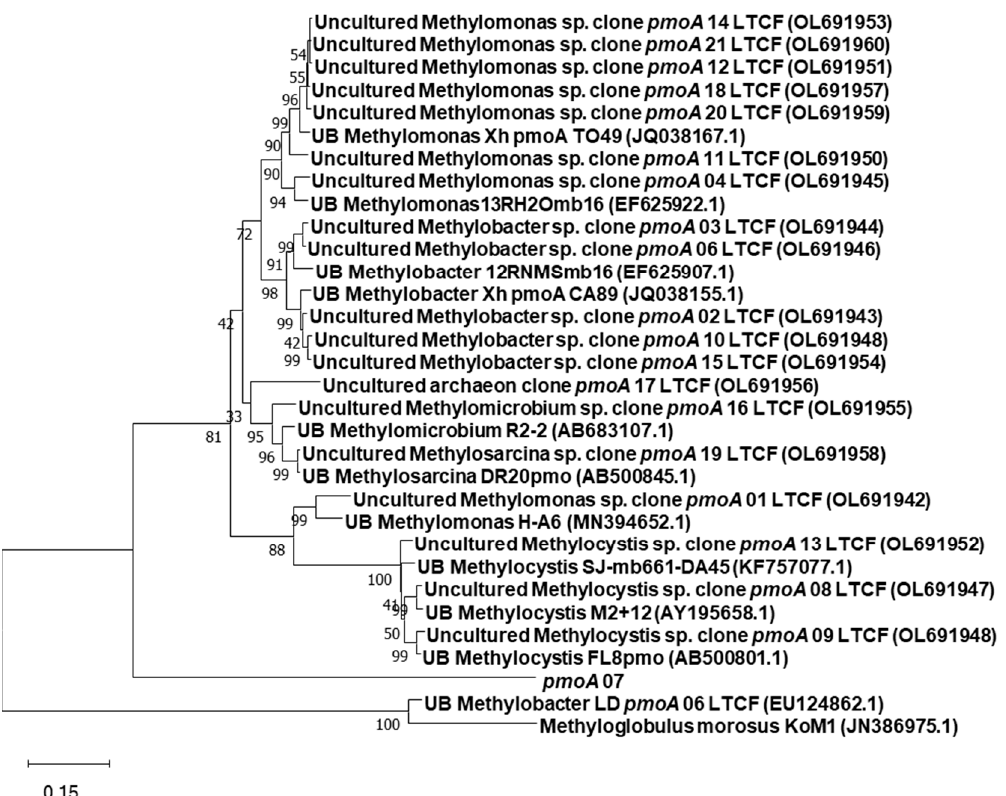
Figure 2. Phylogenetic tree showing the relationship between the partial pmoA DNA sequences of methane oxidizing bacteria determined in this study with their closest identified sequences re- trieved from GenBank. Bootstrap values are shown at the branch points. The tree is drawn to scale, with the branch lengths in the same unit as those of the evolutionary distances used to infer the phylogenetic tree.